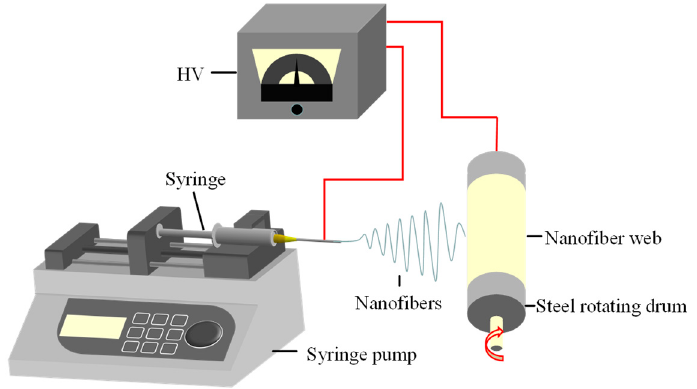
Figure 1. Schematic diagram of electrospinning setup.